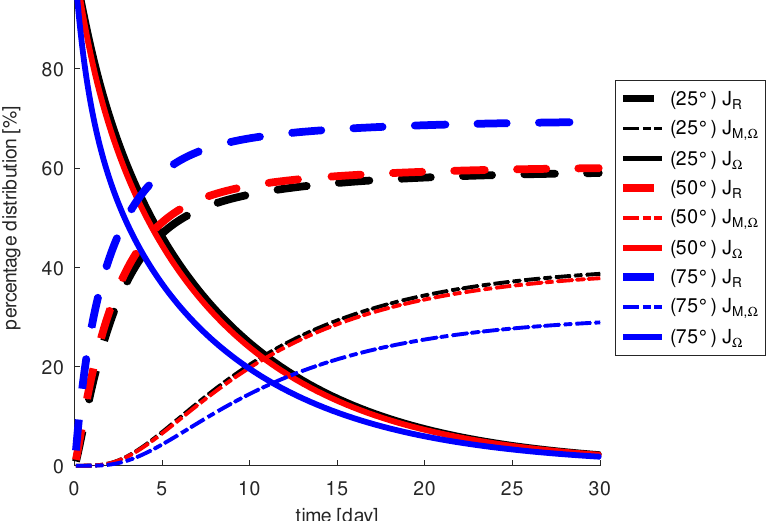
Figure 8. The fraction of the injected drug in the vitreous, J Ω , at the macula, J M , Ω , and at the retina, J R , depending on the penetration angle ψ xy